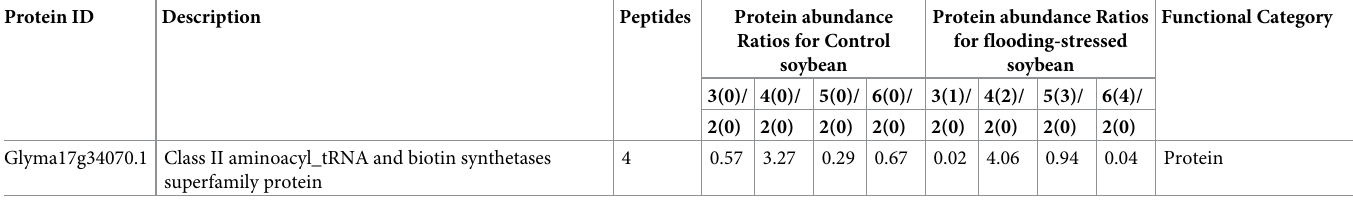
proteins belonged to glycolysis (31 in control, 24 in flooded), amino acid metabolism (27 in both control & flooded), cell (25 in control, 22 in flooded), TCA/organic transformation (20 in control, 12 in flooded), signaling (20 in control, 18 in flooded), secondary metabolism (18 in control, 14 in flooded), development (18 in control, 23 in flooded), redox (17 in control, 19 in flooded), cell wall (17 in control, 16 in flooded), hormone metabolism (16 both in control & flooded), RNA (14 in control, 9 in flooded), transport (12 in control, 11 in flooded), mitochon- drial electron transport (10 in control, 05 in flooded), lipid metabolism (9 in control, 5 in flooded), major CHO metabolism (8 in control, 10 in flooded), mitochondrial metabolism (7 in control, 6 in flooded) and fermentation (7 in control, 8 in flooded). The 25 proteins in con- trol and 16 in flooded belonged to miscellaneous; while 22 in control and 31 proteins in flooded seedlings were not assigned any function. The ‘Others’ category included proteins related to organo-pentose phosphate pathway, C1-metabolism, minor carbohydrate metabo- lism, DNA, metal handling, biodegradation of xenobiotics, cofactor and vitamin metabolism, and photosynthesis. Proteins belonging to protein-metabolism category were sub-categorized (Fig 3B). These belonged to protein synthesis (76 in control, 63 in flooded), protein degrada- tion (39 in control, 29 in flooded), protein folding (21 in control, 14 in flooded) and others (16 in control, 11 in flooded). Those grouped in others included proteins related to post-transla- tional modifications, targeting and amino acid activation.